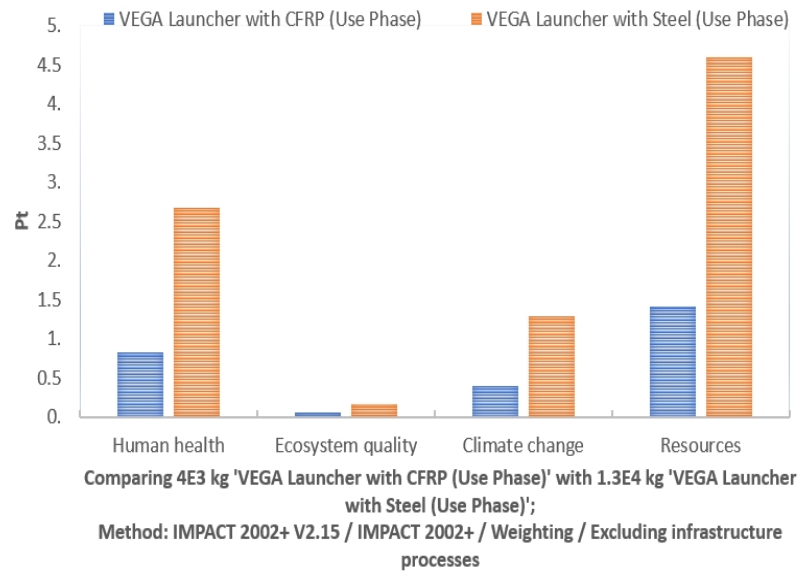
Figure 7. LCA results of comparison of use phase of stainless steel and CFRPs into endpoint categories.